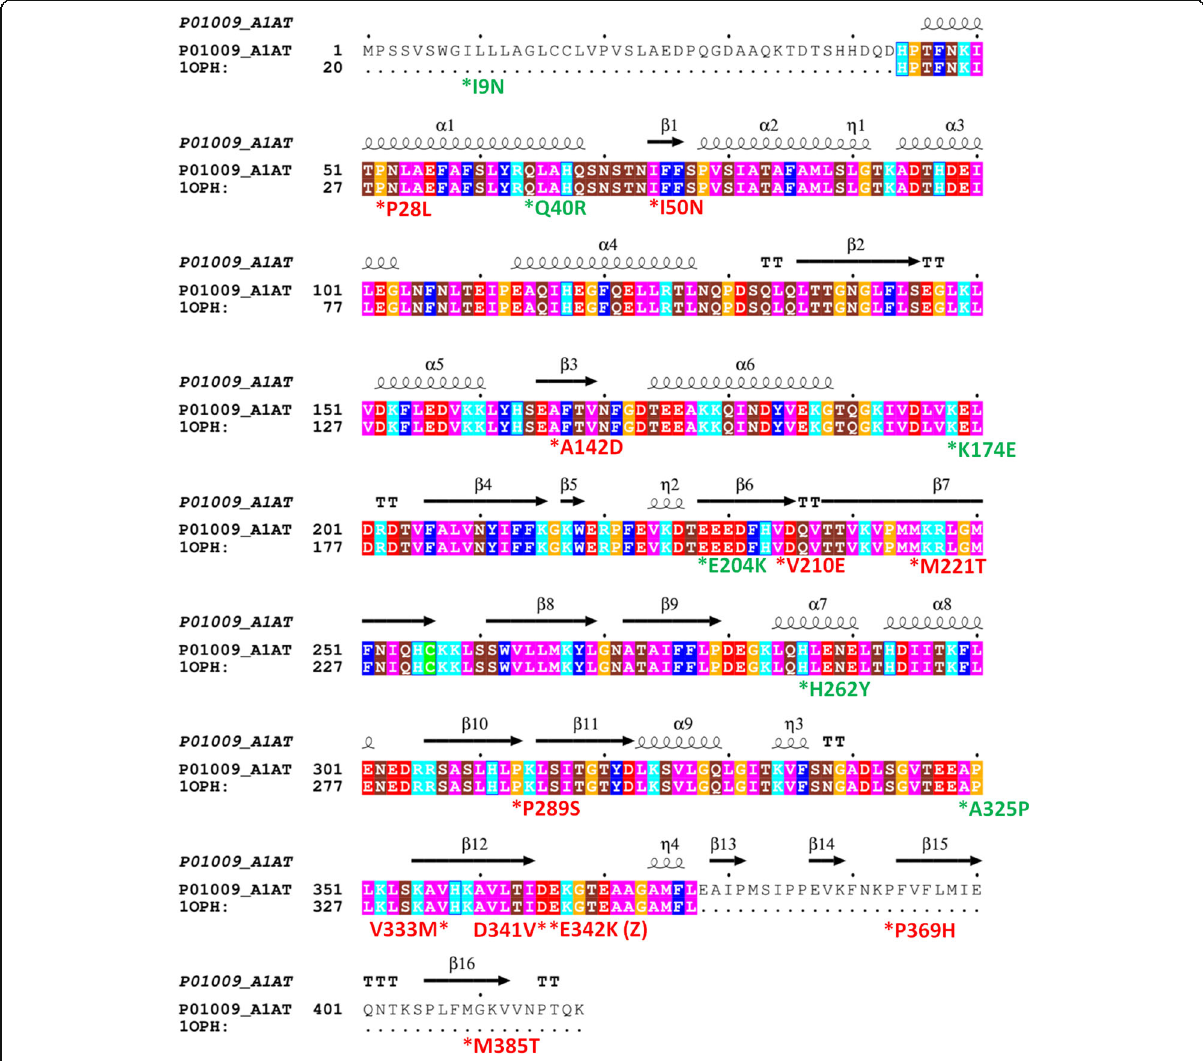
Fig. 2 Primary and secondary structure of AAT. While the top row sequence represents Uniprot numbering including the signal peptide, the bottom sequence row uses the conventional numbering for AAT found in the broad literature, and used throughout this manuscript. Color coding of residues are according to chemical properties, and display of secondary structural elements (arrow for β -strand, curl for α -helix as extracted from PDB code 1OPH) are shown above the sequences using the software package ESPript [13]. The positions of the novel alleles reported in this manuscript are marked by an asterisk below the residue, and include the variant residue found. Those that are probably or possibly deleterious are colored red, and those that are possibly or probably neutral are colored green. Numbering of the variants, apart from I9N, does not include the 24 amino acid precursor. AAT, Alpha 1